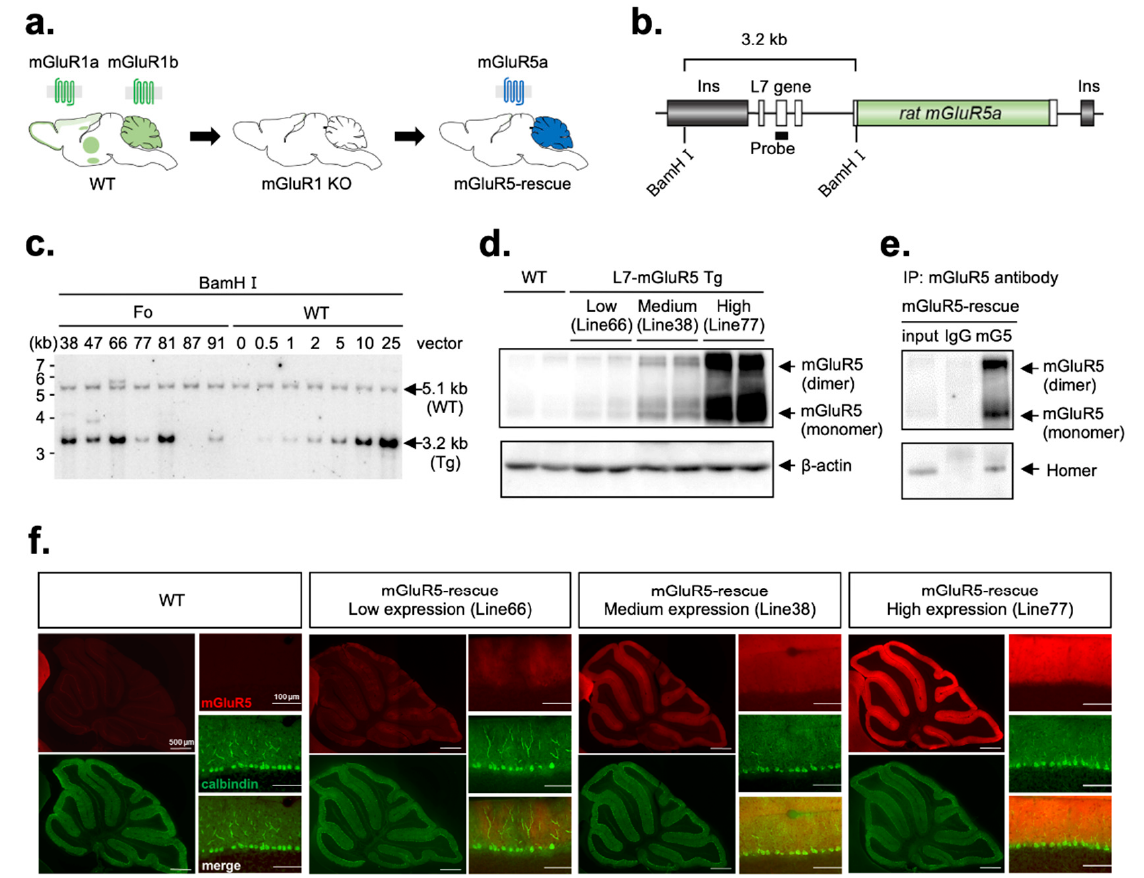
Figure 1. ( a ) Strategy for the generation of mGluR5-rescue mice. ( b ) Schematic structure of the transgene construct with Southern blot strategy. Rat mGluR5a cDNA was inserted into the L7 cassette. Open boxes represent exons of the L7 gene (exons 1-4). To avoid the position effect, the L7-mGluR5a transgene is flanked by insulator sequences (gray boxes) from chicken globin gene. ( c ) Southern blot analysis of tail DNA. Seven founder mice (ID: 38, 47, 66, 77, 81, 87, and 91) were obtained. We detected 5.1 kb and 3.2 kb bands derived from endogenous and transgenic L7 genes, respectively. To estimate the copy number of transgenes, the intensity of the transgene band of each transgenic mouse was compared with those of the standard DNA (wild-type (WT) mouse DNA with 0.5, 1, 2, 5, 10, and 25 copies of transgene vector DNA added per genome). ( d ) Western blot analysis of mGluR5 proteins in the cerebella of WT and L7-mGluR5 Tg mice. We obtained three transgenic lines of L7-mGluR5 Tg mice with different expression levels of mGluR5 (mGluR5 expression: Line66 < Line38 < Line77). β -actin was used as control. ( e ) Co-immunoprecipitation of mGluR5 and Homer. Synaptosomal fraction from the cerebellum of mGluR5-rescue High mice was incubated with antibody to mGluR5 (mG5). Subsequently, the input and the proteins bound to mGluR5 and IgG were immunoblotted using antibodies against the mGluR5 and Homer. ( f ) Immunohistochemical analysis for mGluR5-rescue mice. Parasagittal sections from WT and three transgenic lines of mGluR5-rescue mice (Low, Medium, and High) stained with antibody to mGluR5 (red) and antibody to calbindin (green). mGluR5 was expressed in molecular layer of cerebellar cortex in mGluR5-rescue